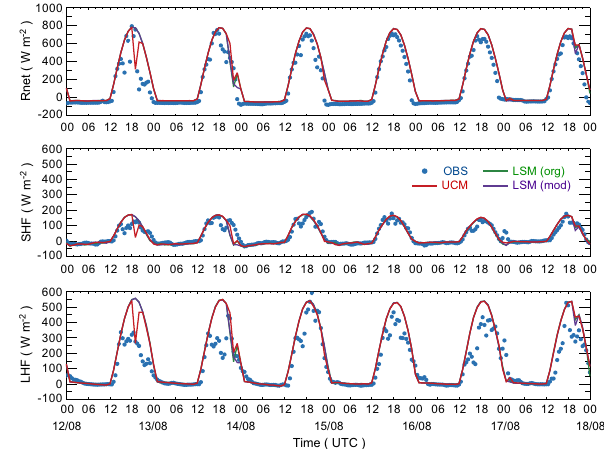
Fig. 9. Diurnal variations of the observed and simulated net all- wave radiation, sensible heat flux, and latent heat flux (top to bot- tom) at the Kirbyville site from 12 to 17 August 2006. This site is represented as a needle leaf forest area in the model.